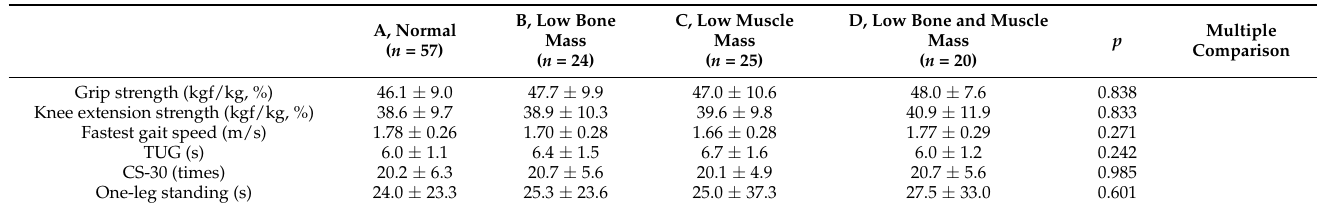
Table 3. Comparison of physical functions of elderly participants in late elderly stage among the four groups.